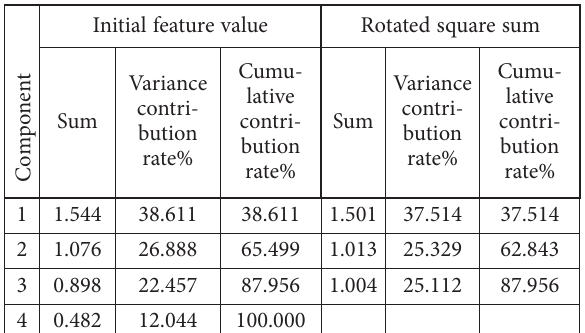
Table 5. Characteristic values and variance contribution rates (the aeolian sand region)